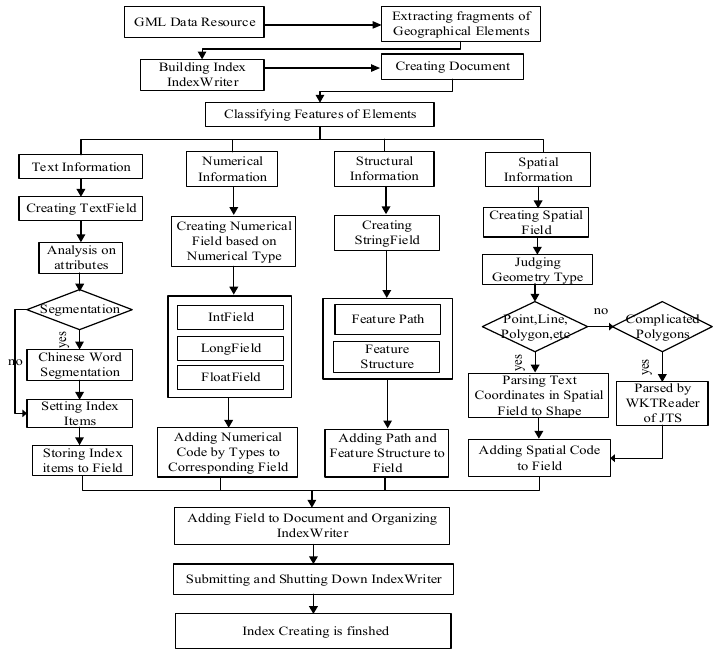
Figure 6. Process of constructing of GML index.